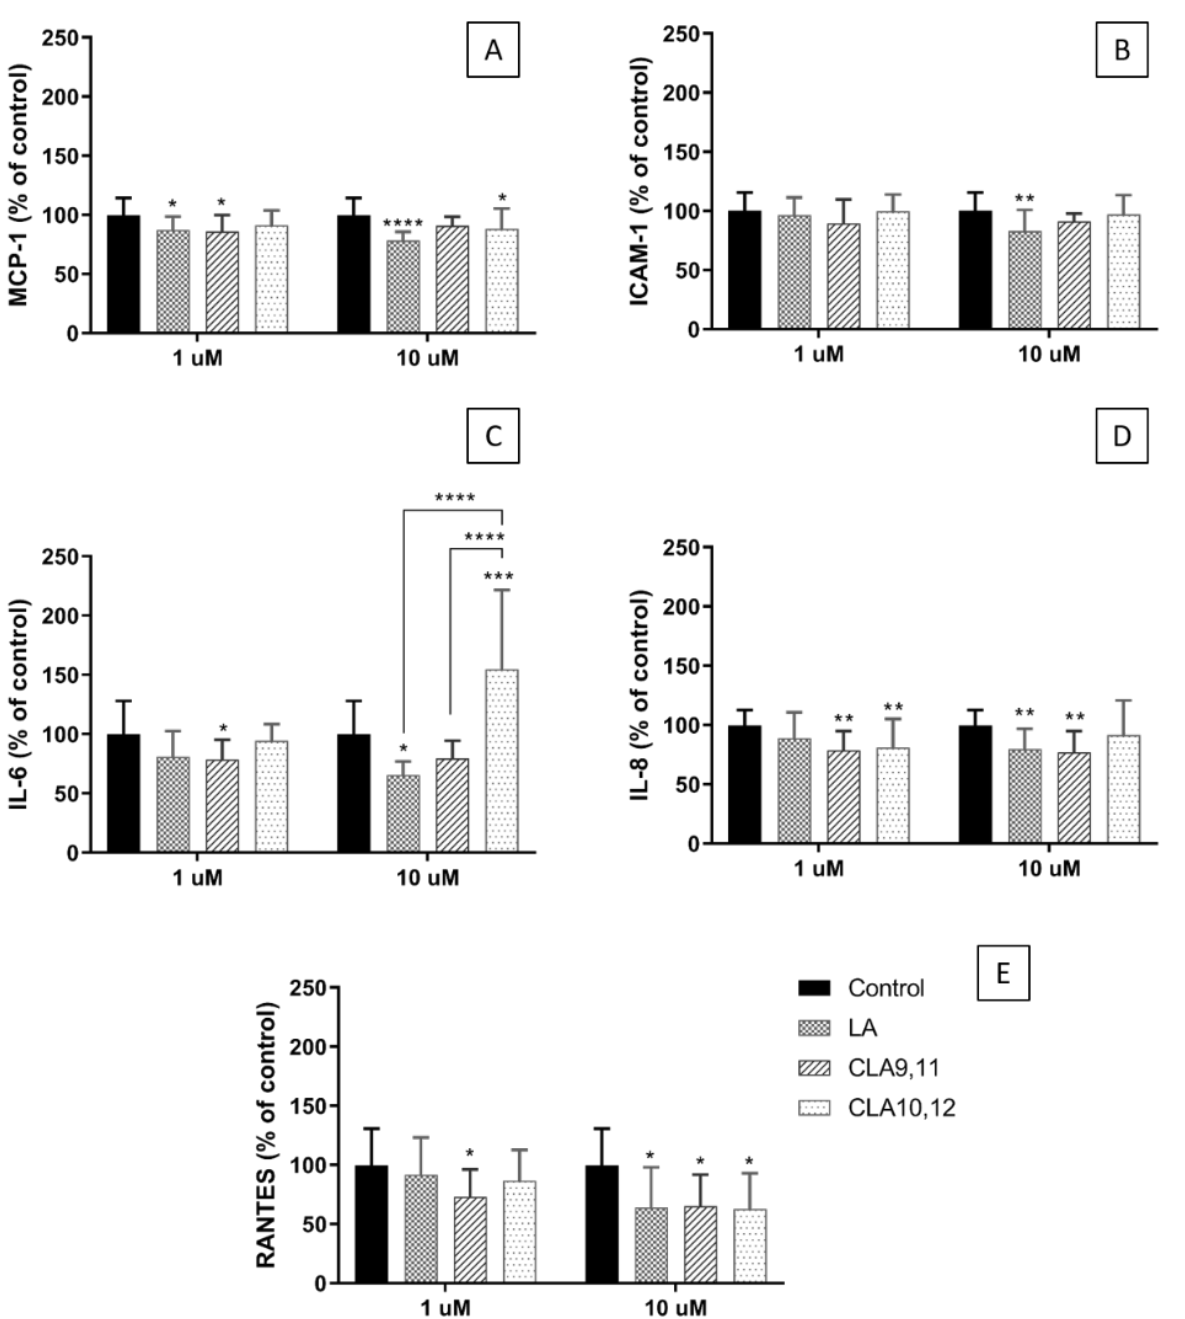
Figure 2. Concentrations (% of control) of MCP-1 ( A ), ICAM-1 ( B ), IL-6 ( C ), IL-8 ( D ) and RANTES ( E ) in the medium of EA.hy926 cells incubated for 48 h with medium containing 0.1% of ethanol (Control) or fatty acid at 1 or 10 µM, followed by incubation with a medium without fatty acids for 24 h. Bars are mean ± SD of 9 samples from 3 experiments. Data were analysed using the one-way ANOVA with Tukey’s post hoc test. * p < 0.05; ** p < 0.01; *** p < 0.001; **** p < 0.0001; where asterisks are shown immediately above a bar they refer to the difference from the control and where asterisks are shown above a horizontal line they refer to the differences between the two groups indicated by that line. LA, linoleic acid; CLA9,11, cis -9, trans -11 linoleic acid; CLA10,12, trans -10, cis -12 linoleic acid.